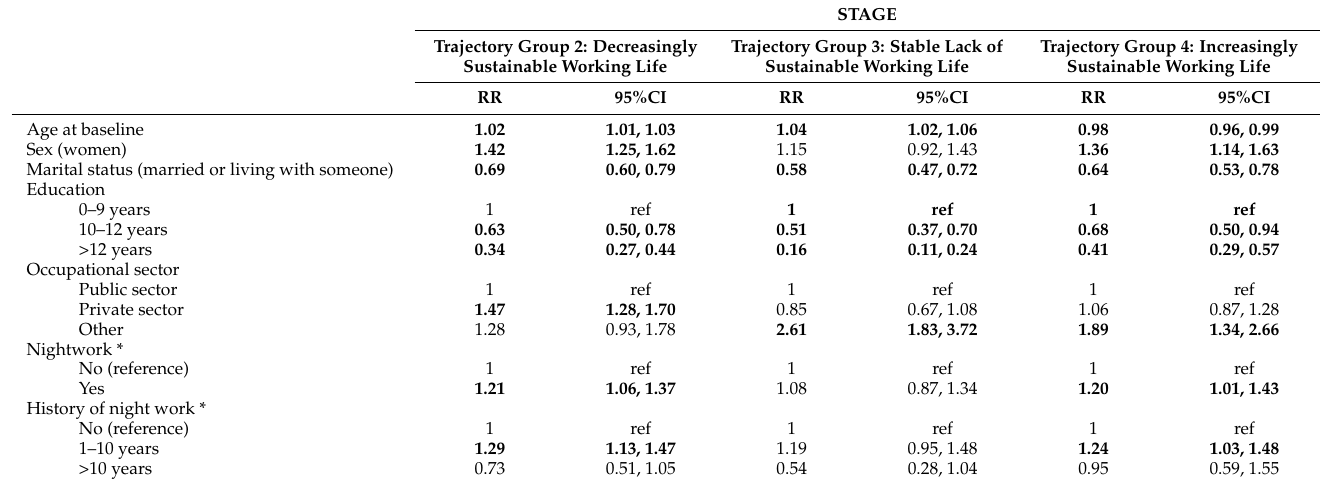
Table 4. Relative-risk ratios (RRs) with 95% confidence intervals (CIs) for sociodemographic factors and night work in relation to the sustainable working life trajectory groups in the STAGE cohort (with trajectory group 1 (sustainable working life) as a reference). STAGE Trajectory Group 2: Decreasingly Trajectory Group 3: Stable Lack of Trajectory Group 4: Increasingly Sustainable Working Life Sustainable Working Life Sustainable Working Life RR 95%CI RR 95%CI RR